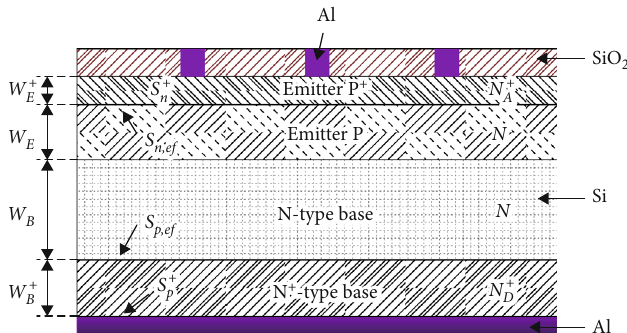
Figure 1: The structure of the analysed photovoltaic cell.